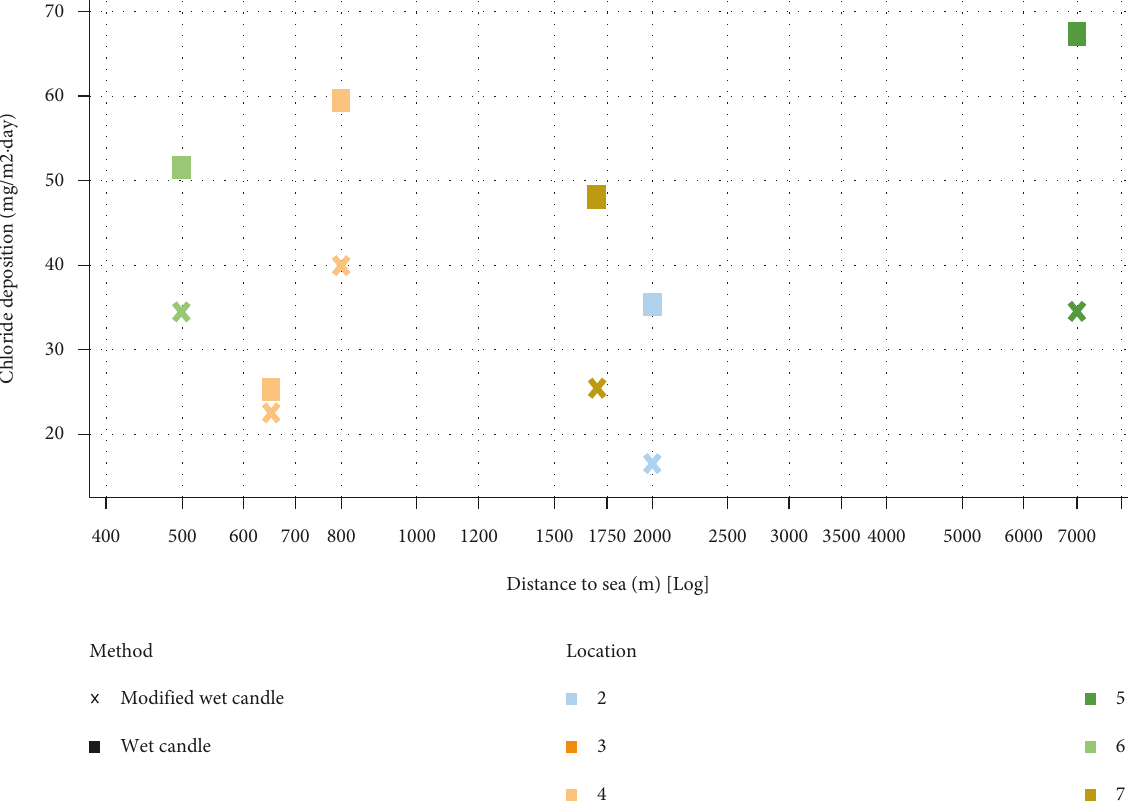
Figure 10: Representation of chloride deposition versus distance to coast in test